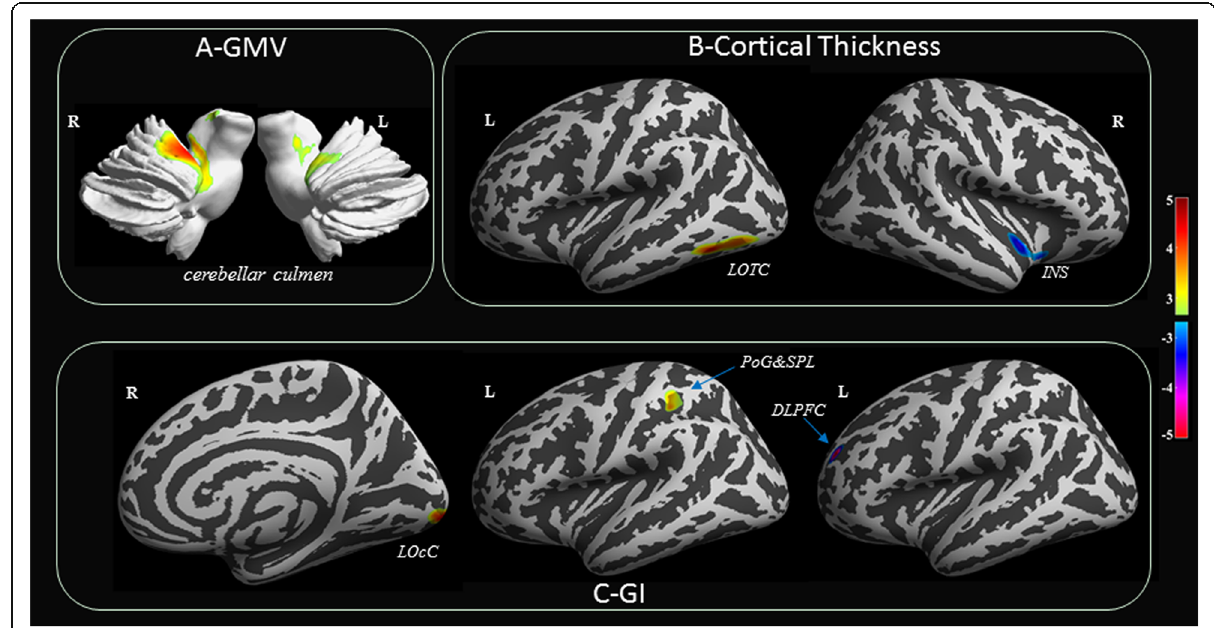
Fig. 1 The structural differences in gray matter between migraineurs without aura and healthy controls. a, compared with controls, the migraineurs without aura exhibited significantly increased gray matter volume in bilateral cerebellar culmen (lobule I-IV and lobule V). b, cortical thickness was significantly thicker in the left LOTC, and significantly thinner in the right INS in migraineurs without aura than in the healthy controls. c, the GI were significantly increased in the left POG, the SPL and the right LOcC, and decreased in the left DLPFC in the migraineurs. LOTC lateral occipital-temporal cortex, INS insula, POG postcentral gyrus, SPL superior parietal lobule, LOcC lateral occipital gyrus, GI gyrification index, GMV gray matter volume